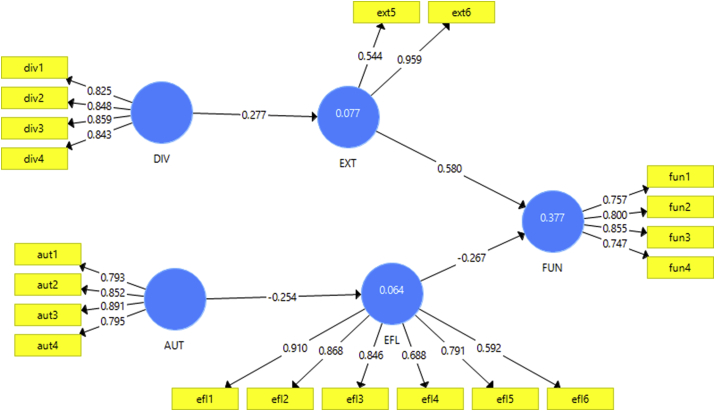
Pictorial representation of Table 4.